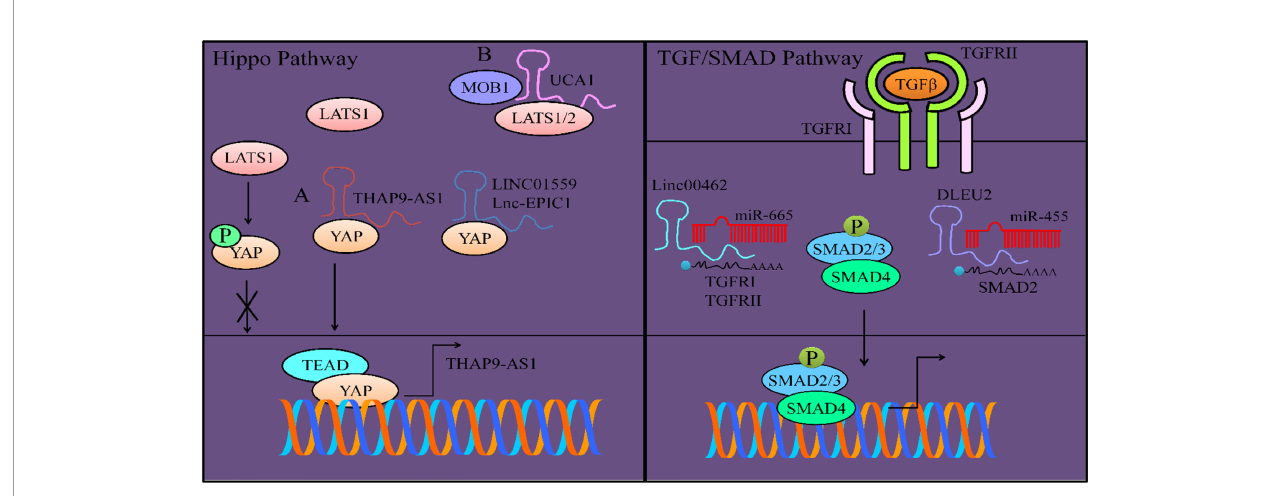
FIGURE 1 | Regulation of Hippo pathway. LATS1 mediated phosphorylation of YAP prevented its nuclear accumulation. However, (A) THAP9-AS1 inhibited LATS1 mediated phosphorylation of YAP and promoted its nuclear accumulation. YAP interacted with TEAD and transcriptionally upregulated THAP9-AS1. LINC01559 and UCA1 also inhibit phosphorylation of YAP and promote its nuclear accumulation. (B) UCA1 formed a complex with MOB1 and LATS1/2 and not only inhibited MOB1-mediated activation of LATS1/2 but also blocked phosphorylation of YAP. TGF b /SMAD pathway is regulated by lncRNAs. Linc00462 enhanced the expression of TGFRI and TGFRII by interfering with miR-665-mediated targeting activity. DLEU2 also served as an oncogenic lncRNA and inhibited miR-455- mediated targeting of